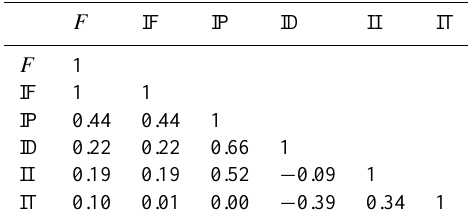
Table 3. Cross-correlation coefficient (lag = 0) of yearly time se- ries of floods ( F) and of indexes of floods (IF), precipitation (IP), wet days (ID), precipitation intensity (II), and temperature (IT).